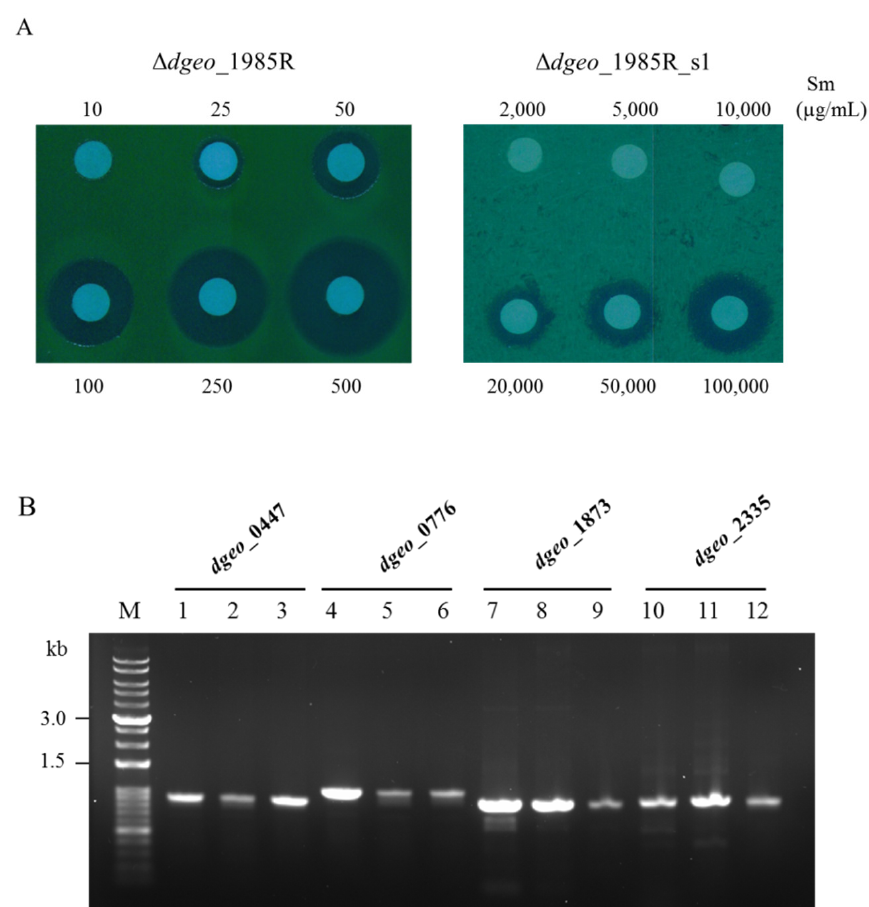
Figure 5. Identification of a streptomycin-resistant mutant from ∆ dgeo _1985R. ( A ) Measurement of streptomycin MIC values between a parent strain and a SmR mutant (s1). ( B ) PCR detection of four SmR related genes ( dgeo_ 0447 (0.9 kb), dgeo _0776 (1.05 kb), dgeo _1873 (0.9 kb), and dgeo _2335 (0.92 kb)) in a genome created using a parent strain and a SmR mutant. Lanes: M, size marker; 1,4,7, and 10, wild-type; 2,5,8, and 11, ∆ dgeo _1985R parent strain; 3,6,9, and 12, ∆ dgeo _1985R_s1 mutant.